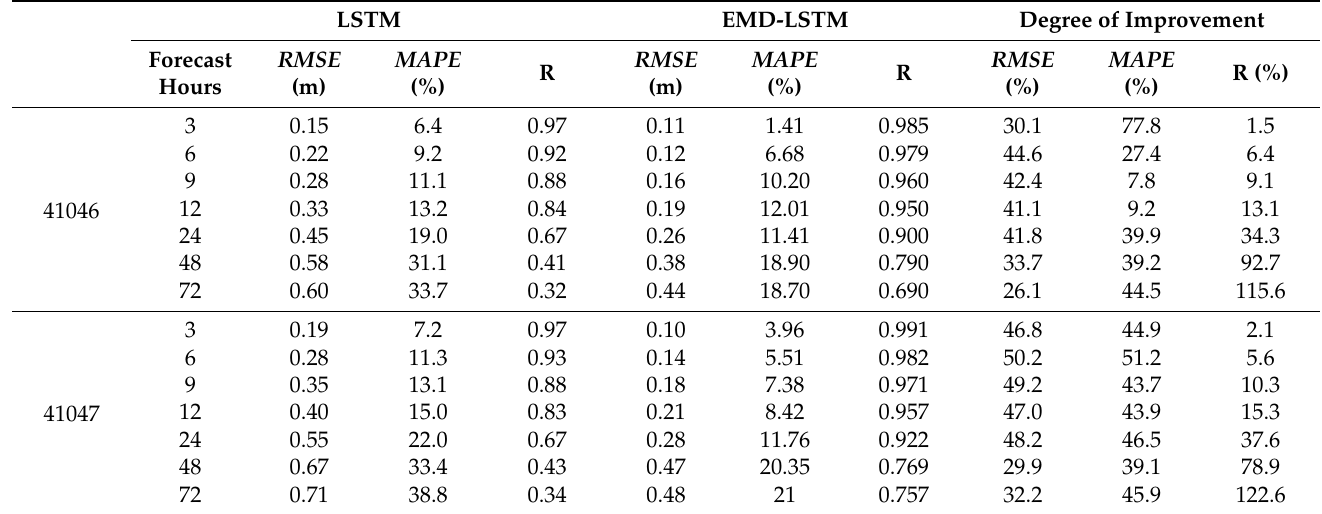
Table 2. Comparison of error statistics between LSTM and EMD-LSTM, in addition to the degrees of improvement for the 3, 6, 9, 12, 24, 48 and 72 h forecast windows for NDBC buoys 41046 and